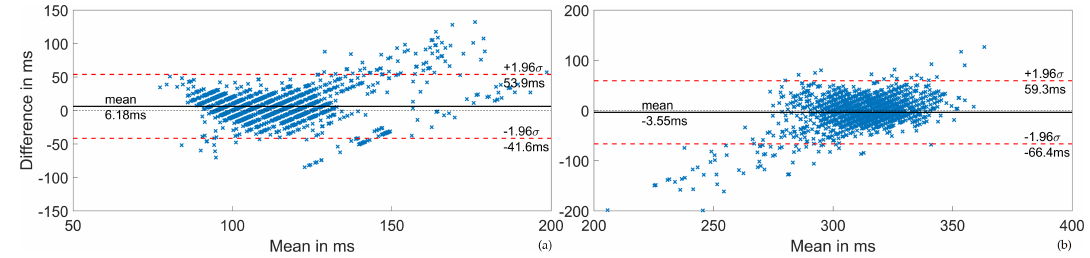
Figure 12. Bland–Altman plots of the STI estimates. ( a ) PEP. ( b )